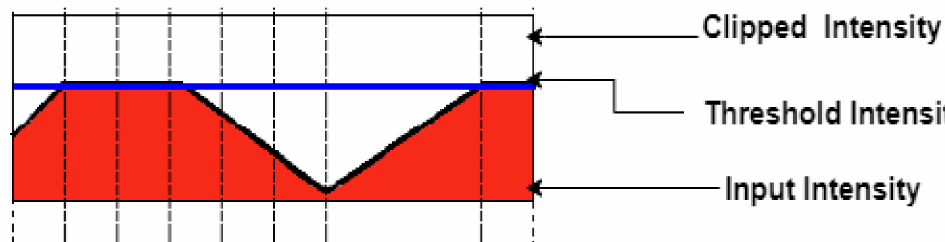
Figure 4. Truncate image thresholding graph.